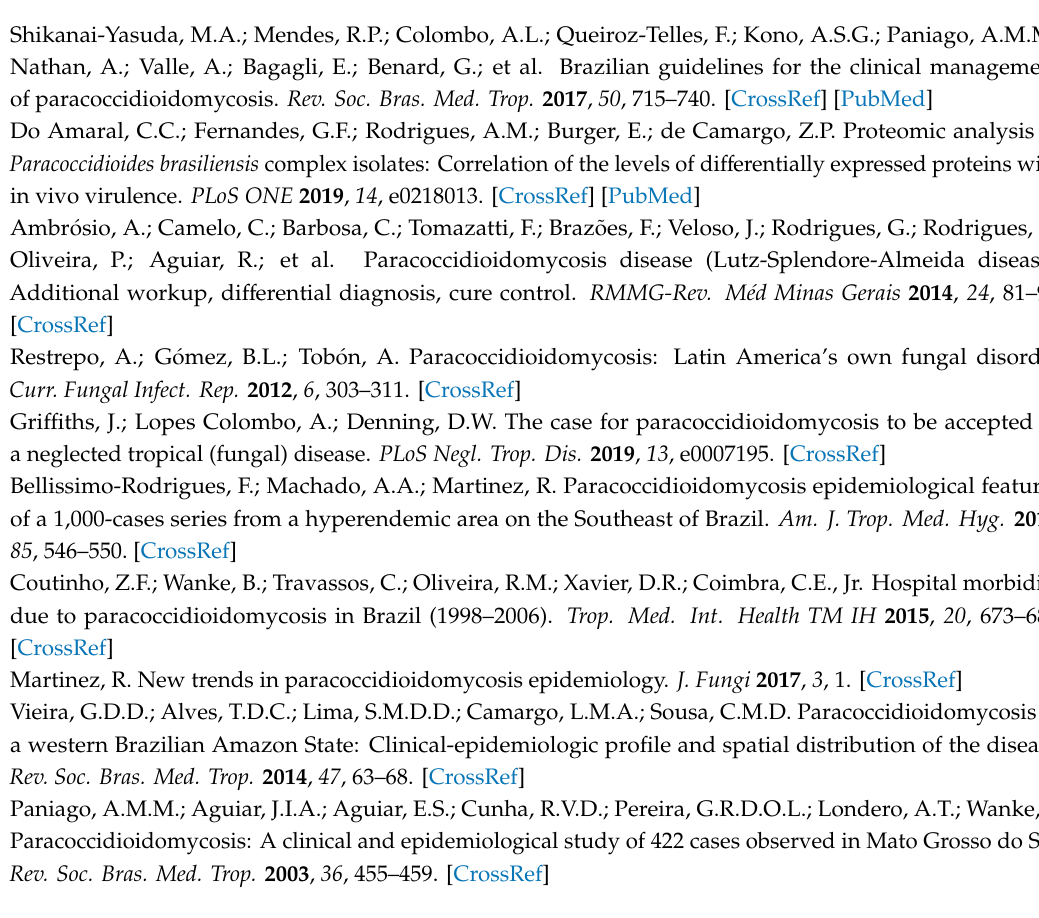
Table S1: Summary of molecular diagnosis methods in